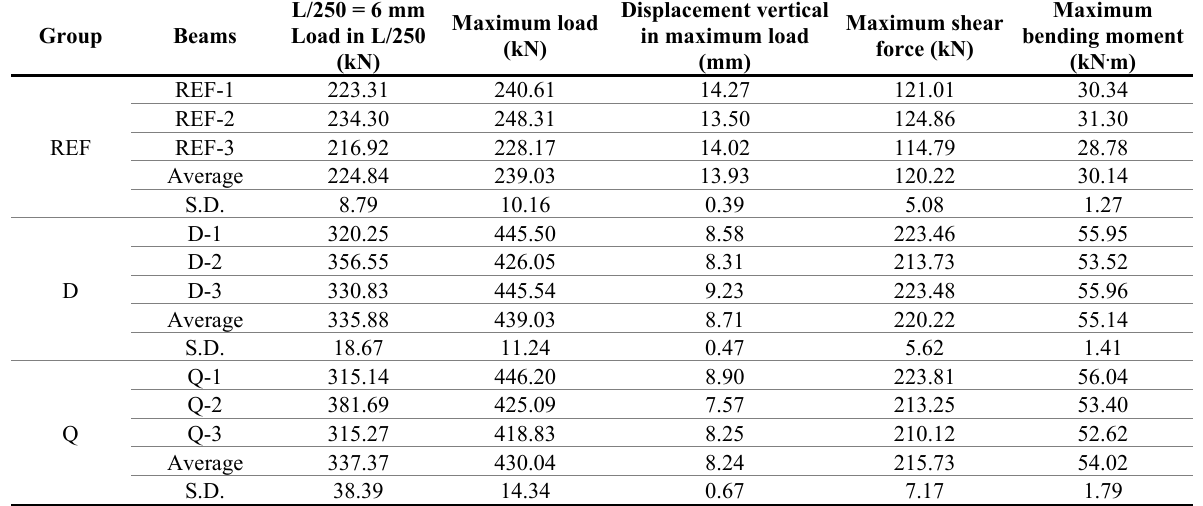
Table 3. Mechanical results for each tested